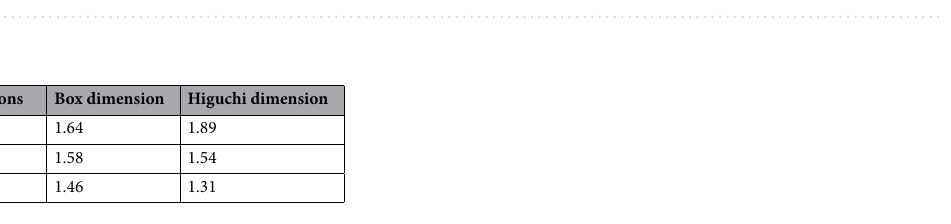
Table 4. The multifractal spectrum shape features of the thorium–uranium distribution in the studied OAE3 intervals.